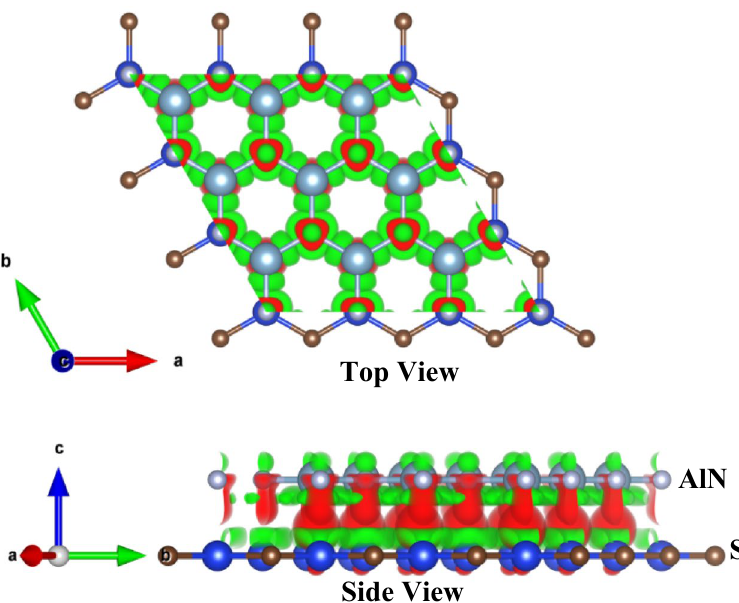
Figure 6. A 3D plot of the charge density difference of the SiC/AlN heterobilayer where the red and the green indicate the areas where the charges are accumulated and depleted, respectively. The isovalue is 0.00286 e/Å 3